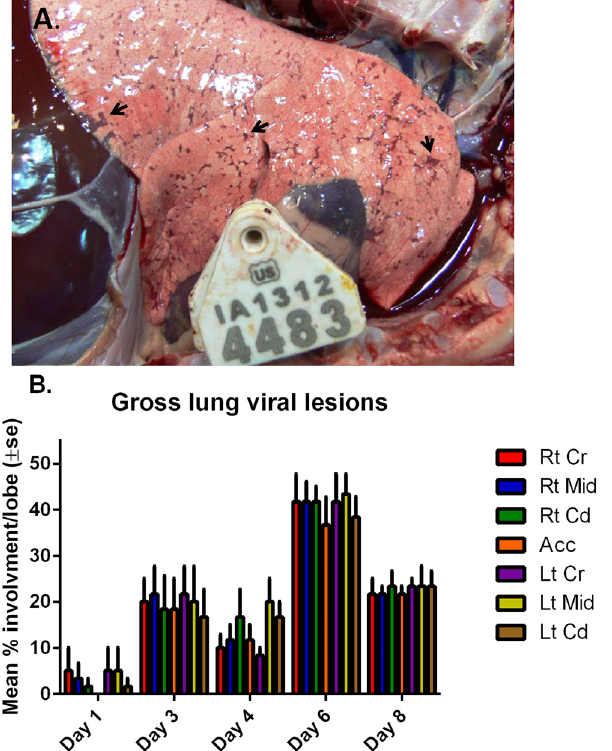
Fig 2. Viral gross lesions caused by M37 hRSV infection in neonatal lambs. (A) Picture of a lung on day 6 post-infection. Dark plum-red, well-demarcated foci of pulmonary consolidation are indicated by arrowheads. (B) Percentage parenchymal involvement was estimated for each lung lobe and mean percentage averages per lobe were calculated for each day of necropsy ( ± standard error). Legend: Rt Cr = Right cranial lobe; Rt Mid = Right Middle lobe; Rt Cd = Right Caudal lobe; Acc = Accessory lobe; Lt Cr = Left Cranial lobe; Lt Mid = Left Middle lobe; Lt Cd = Left Caudal lobe.